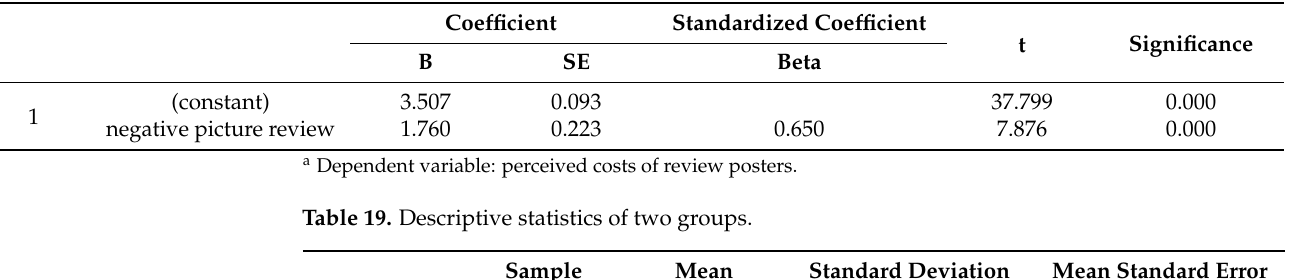
Table 18. Regression coefficients3 of Experiment B a .